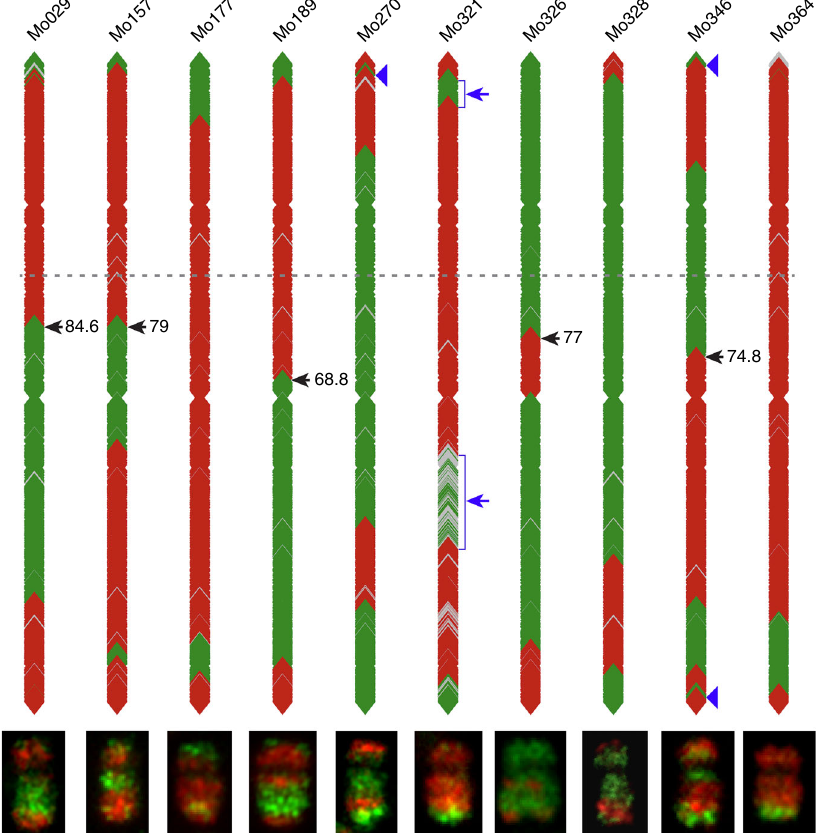
Fig. 6 Schematic illustration of genotyping data and oligo-FISH results of 10 lines from the IBMRIL population. The genotyping data is illustrated by location of markers from B73 (red) and Mo17 (green), respectively. Gray indicates missing genotyping data. A dashed line marks the putative position of the centromere on each of the marker-based diagrams. The regions indicated by blue arrows on Mo321 were not consistently visualized by oligo-FISH. Blue arrowheads on Mo270 and Mo346 point to small regions that were not identi fi ed by oligo-FISH. Black arrows point to the chromosomal exchange positions (EPs) and their fractional length of the arm (FLA), all on the long